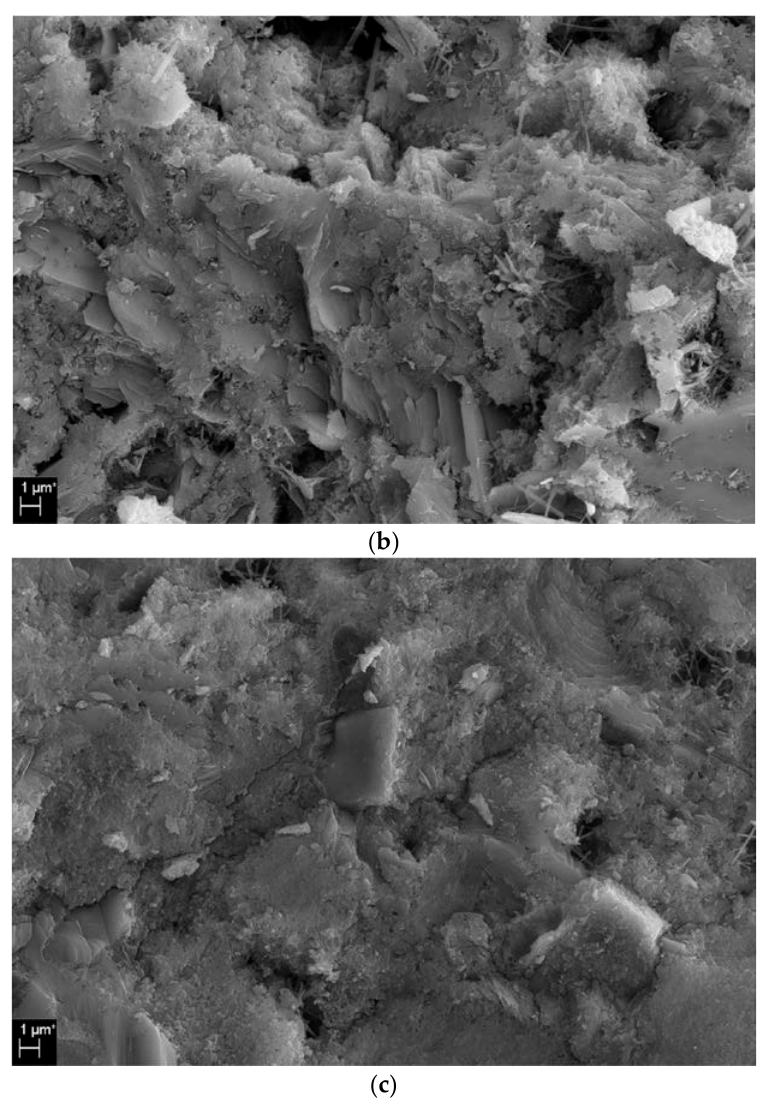
Figure 8. SEM images at 28-day: ( a ) 0% CNS, ( b ) 30% CNS, ( c ) 50% CNS.